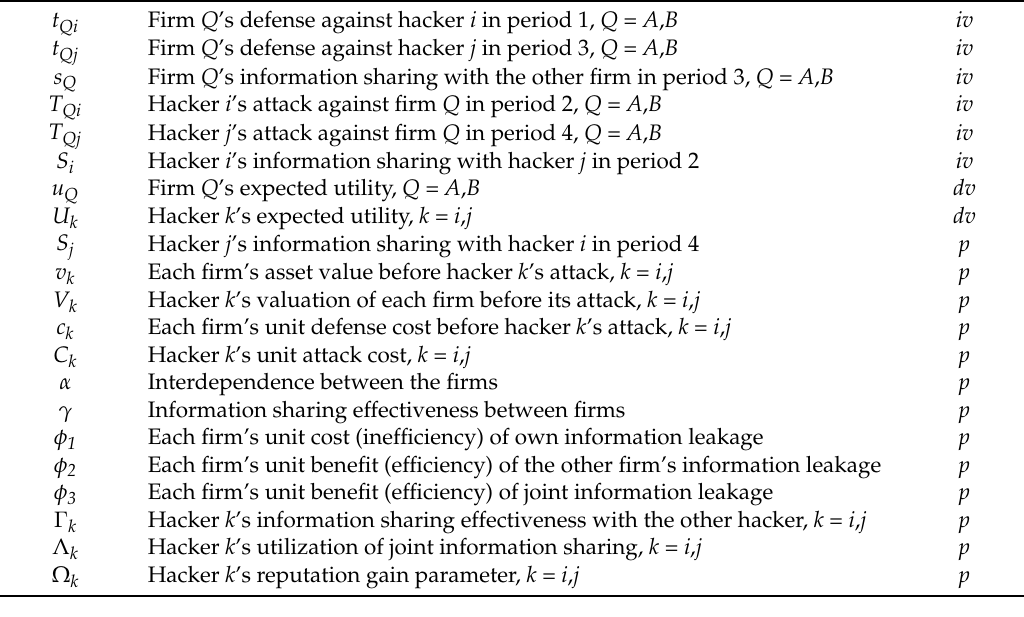
Table 1. Nomenclature, iv = independent variable, dv = dependent variable, p = parameter.